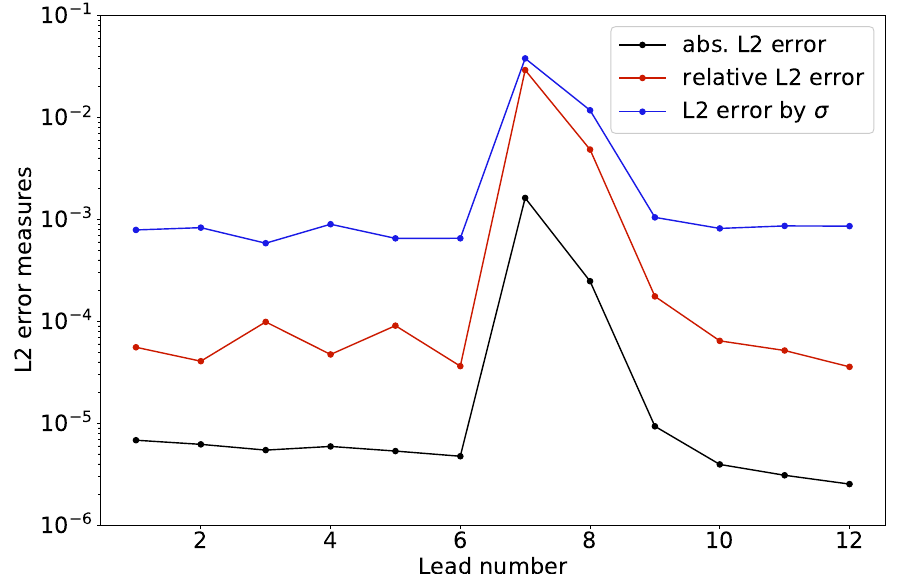
Figure 4. Error measures for the PCE surrogate model. Depicted are the absolute L 2 error ( (cid:101) 2 , black, in mV), the relative L 2 error (cid:101) 2, r (red, cf. Equation (12)) and the L 2 error divided by the standard deviation of the output of the whole dataset (blue, cf. Equation (8)). The PCE surrogates were created in sixth order on the Monte–Carlo sampled dataset (9500 samples for construction and 500 for error estimation). The inter-lead variation is similar to the variance of the sampled dataset, cf. Figure 2, with significantly higher approximation errors for the leads V1 and V2 (numbers 7 and